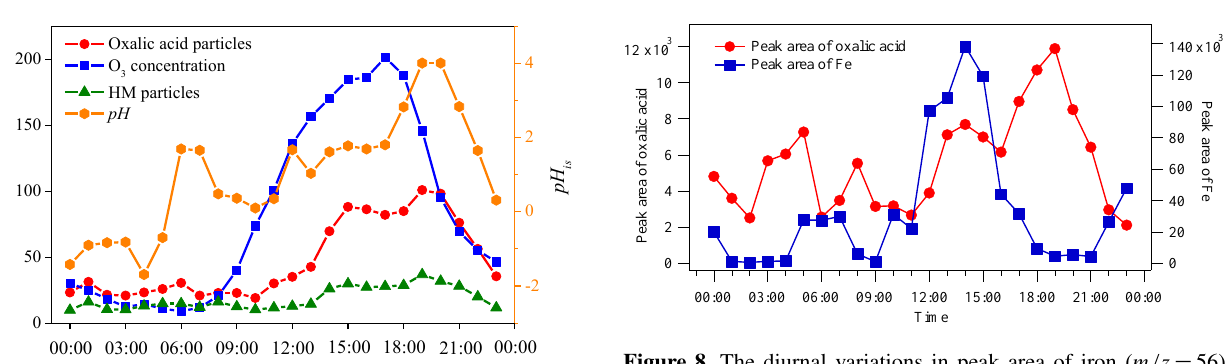
Figure 8. The diurnal variations in peak area of iron ( m/z = 56) and oxalic acid ( m/z =− 89) in the HM oxalic acid particles from 28 July to 1 August